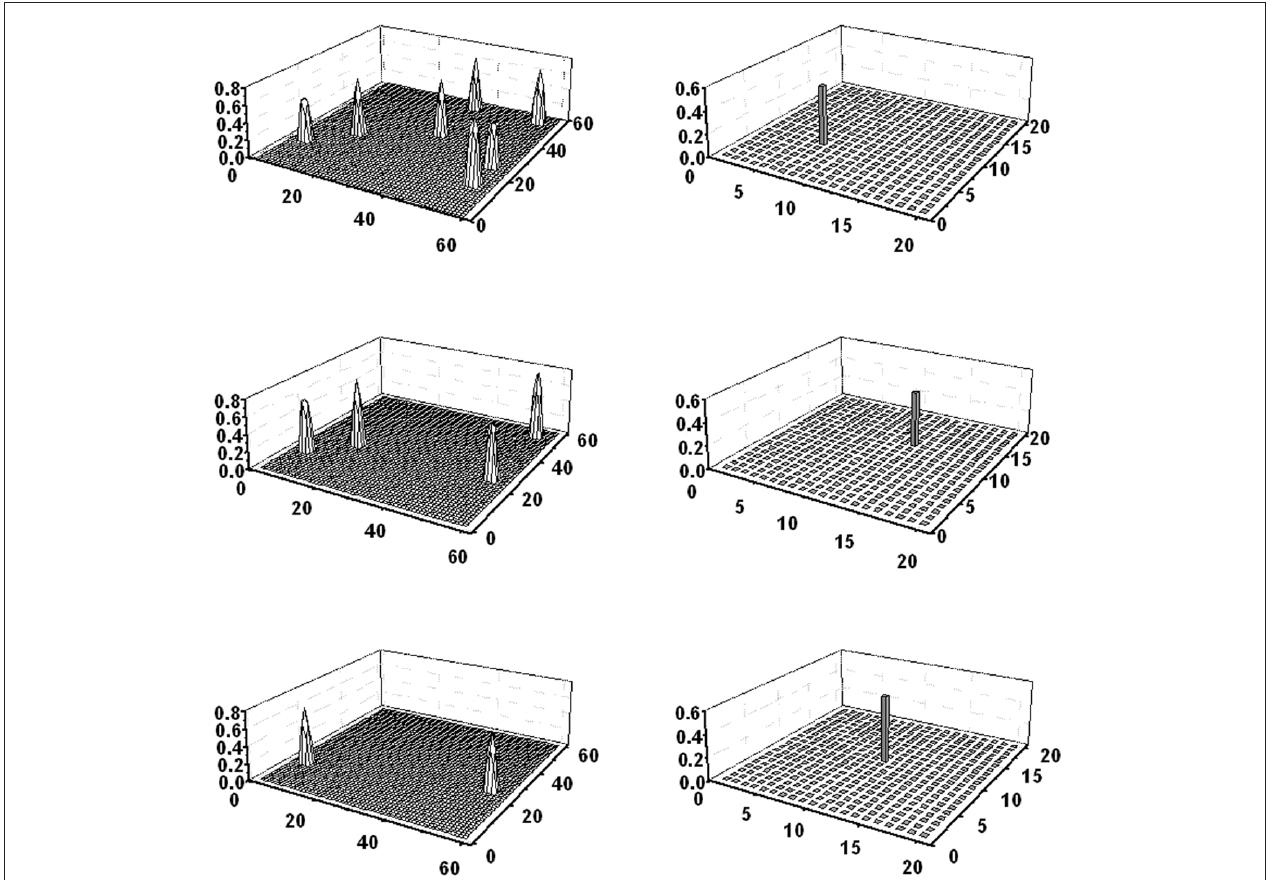
when the two shared features of animal are given to the semantic network, together with a feature of ruminant. The fourth feature of ruminant is restored and the word “ruminant” evoked in the lexical area. Finally, the bottom panel shows a single snapshot obtained by giving the two features of animal to the semantic network. This information does not spread toward other features and the word “animal” is evoked in the lexical